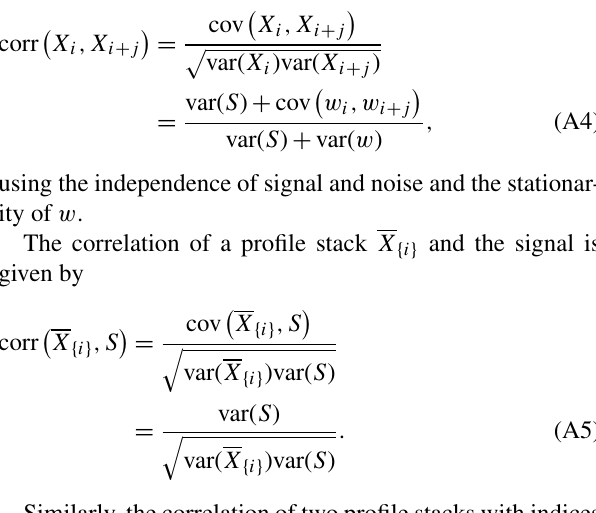
and X i is defined by the 1 1 + i 2